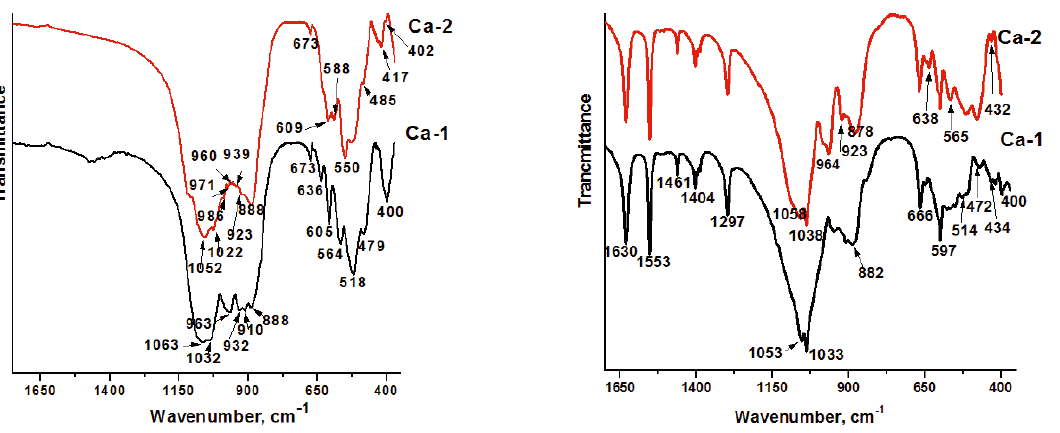
Figure 3. FTIR spectra of synthesized and thermally treated Ca-1 and Ca-2 samples